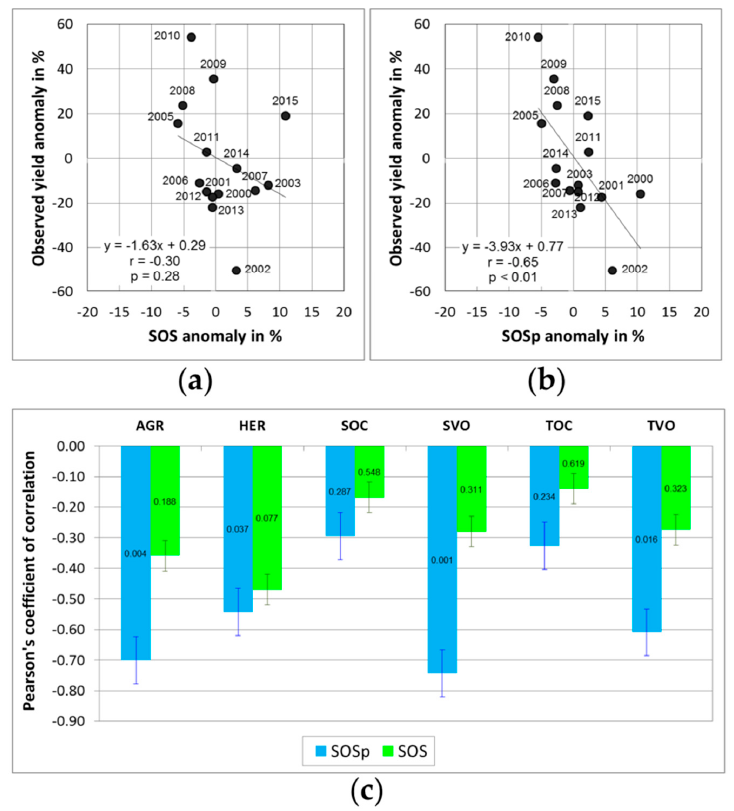
Figure 11. Relationship between anomalies of herbaceous yield mass and onset of: ( a ) the growing season (SOS); ( b ) the rainy season (SOSp) for the whole studied area; ( c ) for each land cover class. Numbers on bars correspond to p-values.